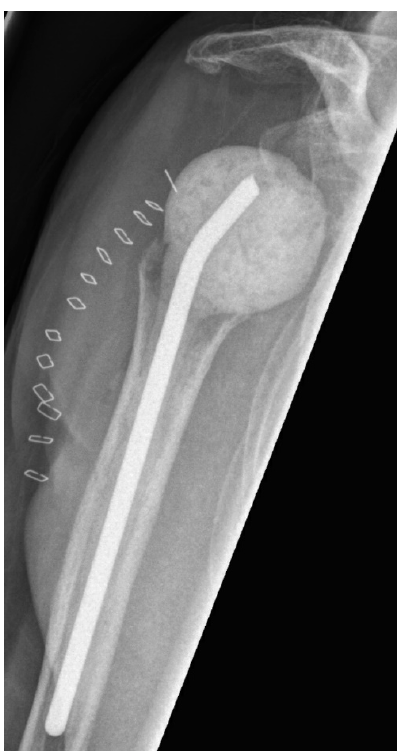
Figure 1. Postoperative anterior–posterior X-ray imaging of a right shoulder after prosthesis explantation and consecutive spacer implantation.